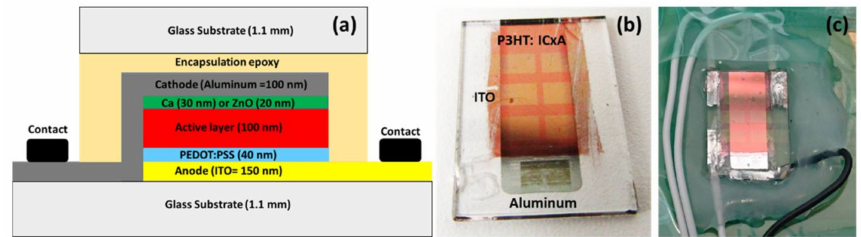
Figure 1. ( a ) The schematic structure of a standard OPV device using either Ca or ZnO as the electron transport layer. ( b ) An actual P3HT:ICxA organic photovoltaic device (active layer thickness 100